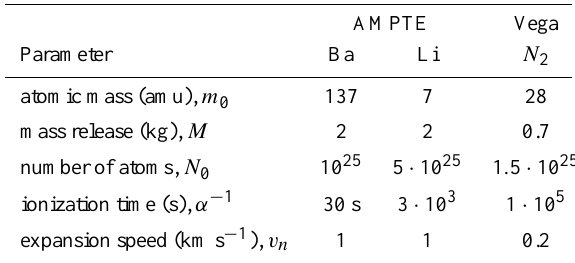
Table 2. Comparison between the AMPTE and Vega